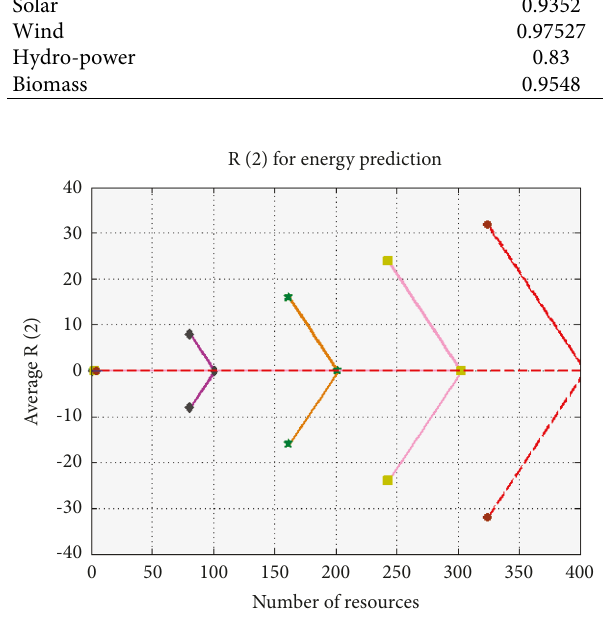
Figure 9: R 2 values in the energy prediction.